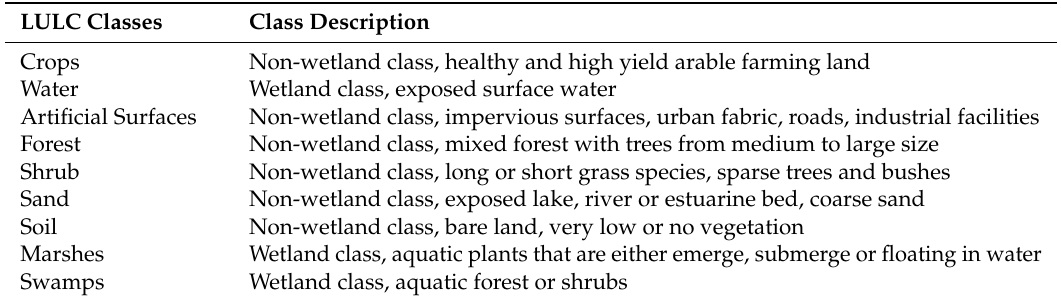
Table 3. Implemented land use/land cover (LULC) classes (first